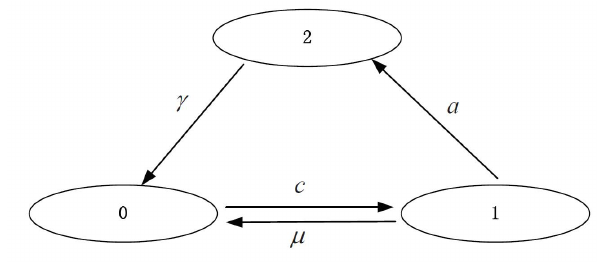
Fig. 1 Diagram of node status changes in consumer social